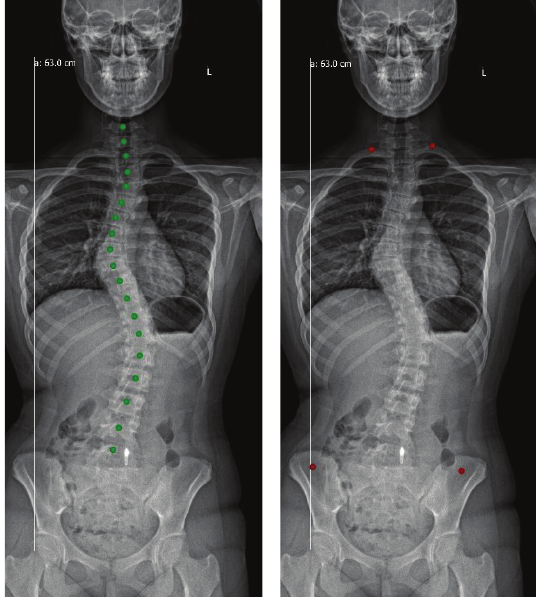
Figure 3. Spine X-ray data set annotation (Left is vertebral center annotation and right is locating points annotation).